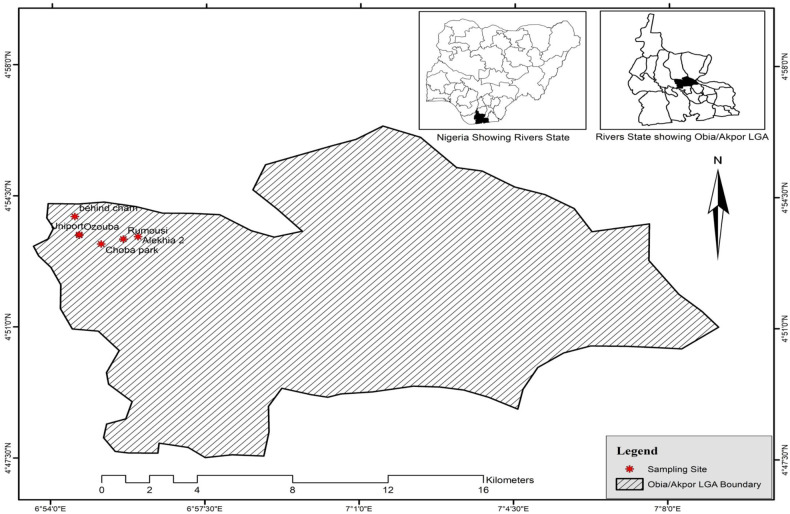
Map of sampling site, showing Obio/Akpor local Government of Port-Harcourt Metropolis, Rivers state, Nigeria.